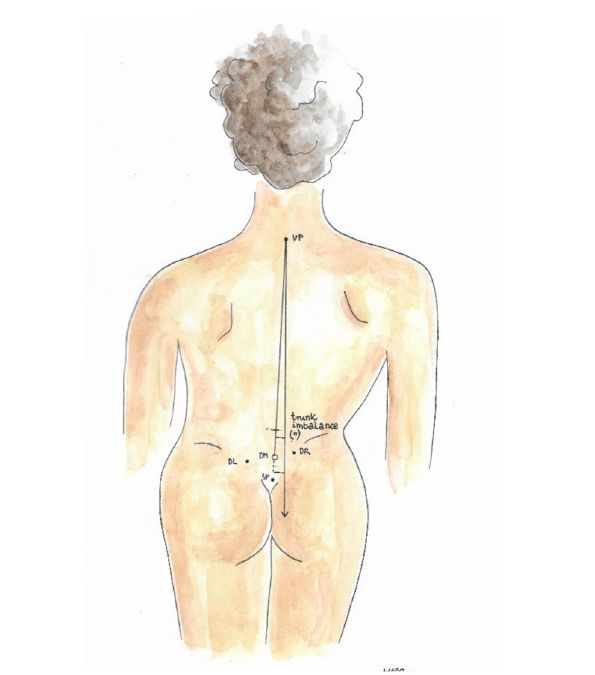
FIGURE 1 | DIERS Formetric (own source).